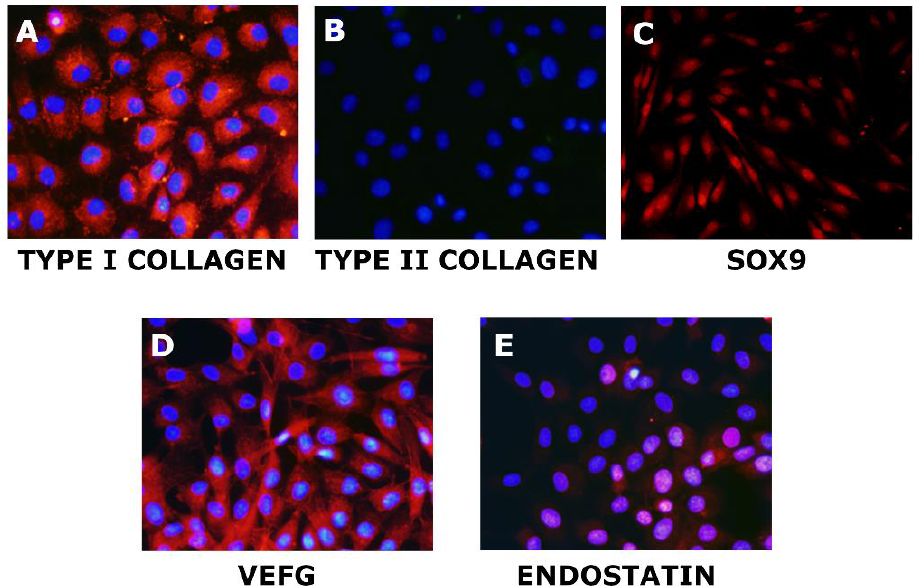
Figure 2. Basal expression of endogenous markers in meniscal cells: positive staining for type I Collagen (Red staining — ( A )), no signal for type II Collagen ( B ), positive staining for SOX9 (Red staining — ( C )), positive signal for VEGF (Red staining — ( D )), positive staining for endostatin (pink staining at a nuclear level — ( E )). The blue signal in all images is the Hoechst staining of cell nuclei.